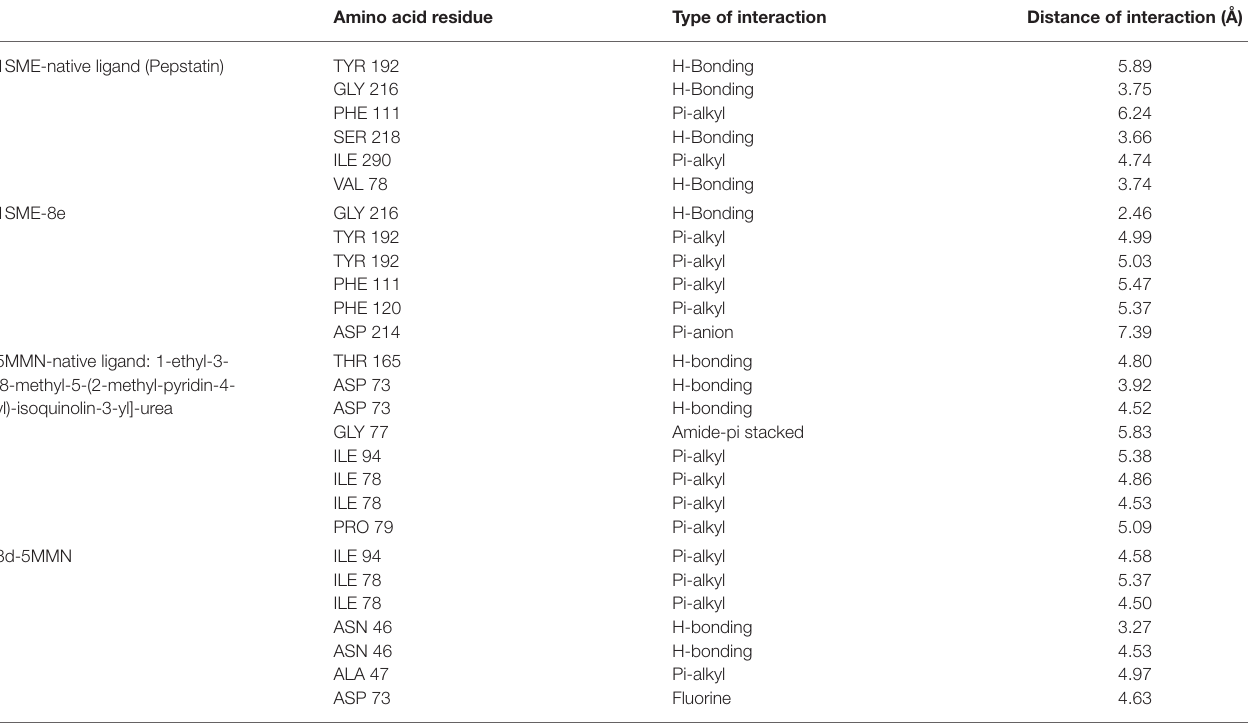
TABLE 3 | Comparison of binding interactions of the native ligands and hit molecule (8e) to the binding sites of 1SME and 5MMN. Amino acid residue Type of interaction Distance of interaction (Å)